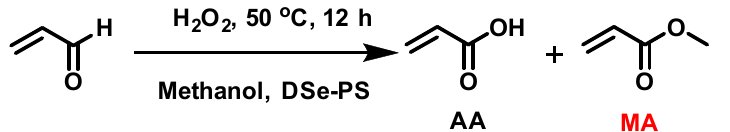
Table 2. Comparation of the product selectivity of selenium-containing catalysts for the oxidation of acrolein in the